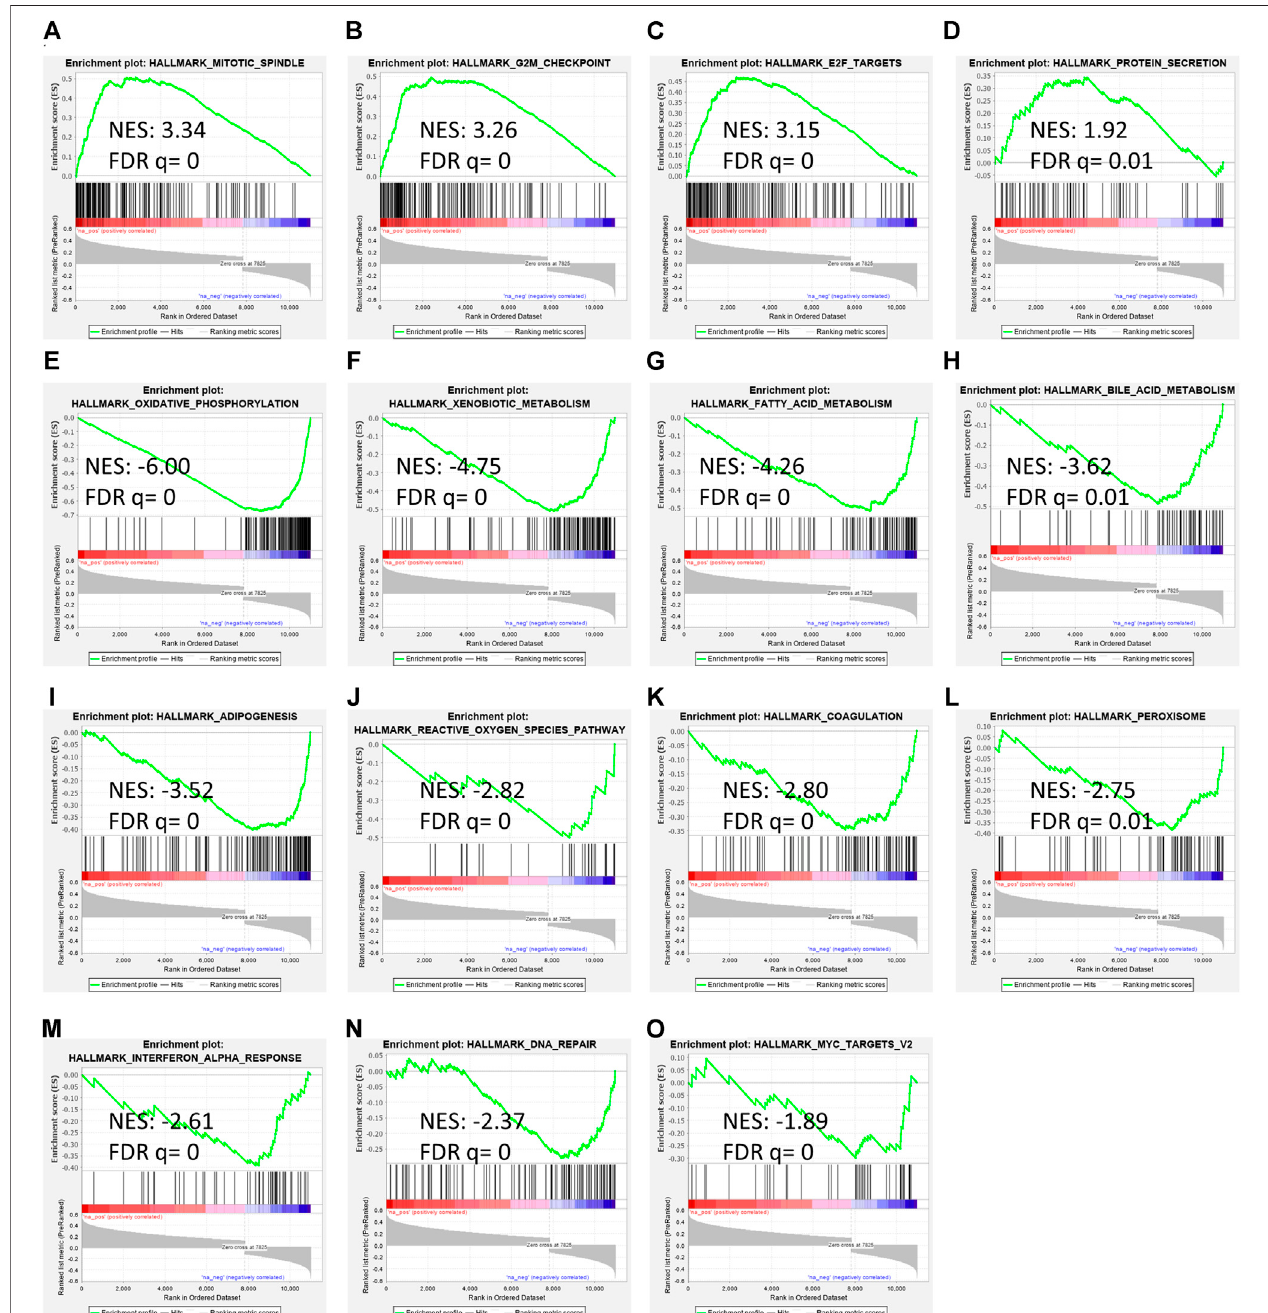
FIGURE8| Geneset enrichmentanalysisofRAP2A correlatedgenesinTCGA-LIHC dataset. (A – D) depicts positivelyenriched pathways (E – L) depictsnegatively enriched pathways with normalized enrichment score (NES), false discovery rate (FDR), and p -value depicted inside the respective pathway.